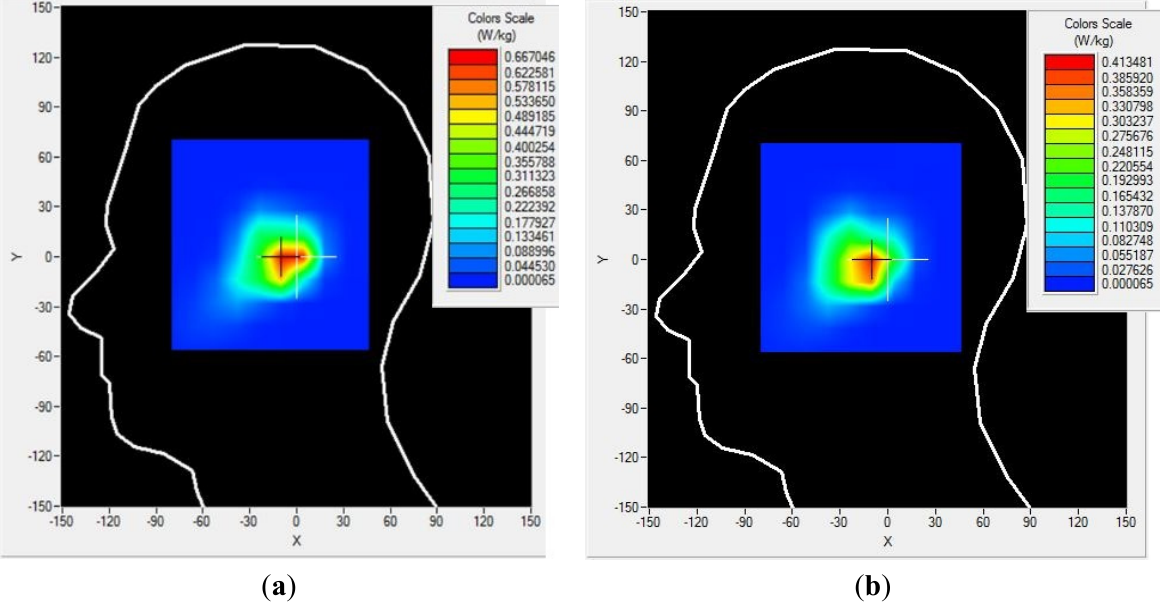
Figure 9. SAR measurement in the Satimo SAR measurement lab.